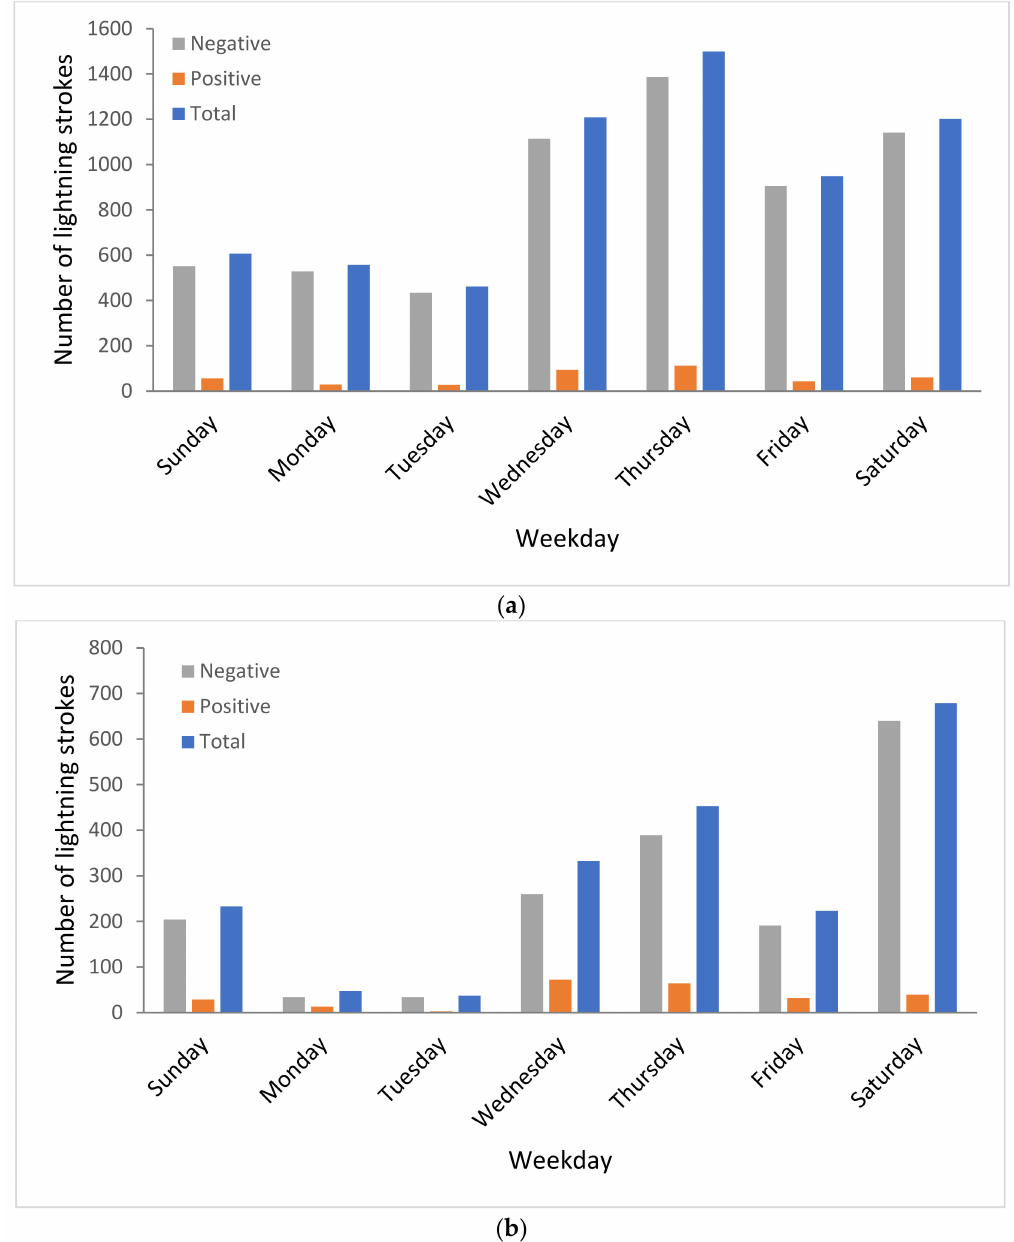
Figure 4. ( a ) The weekly distribution of cloud-to-ground strokes (negative, positive, total) detected by the ILDN over the research area for the full study period. ( b ) The same as ( a ), based on the ENTLN for the 2017/18 and 2021/22 winter seasons. Note the increased numbers on the Saturday, likely due to contribution of the 4.1.2020 extreme event, studied by Lynn et al.